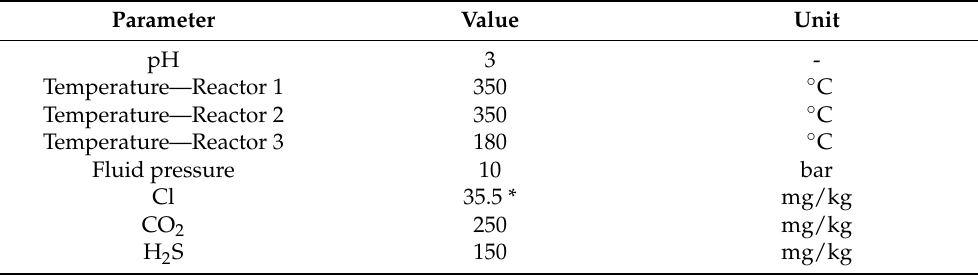
Table 2. Physical conditions and chemical composition of testing fluid.